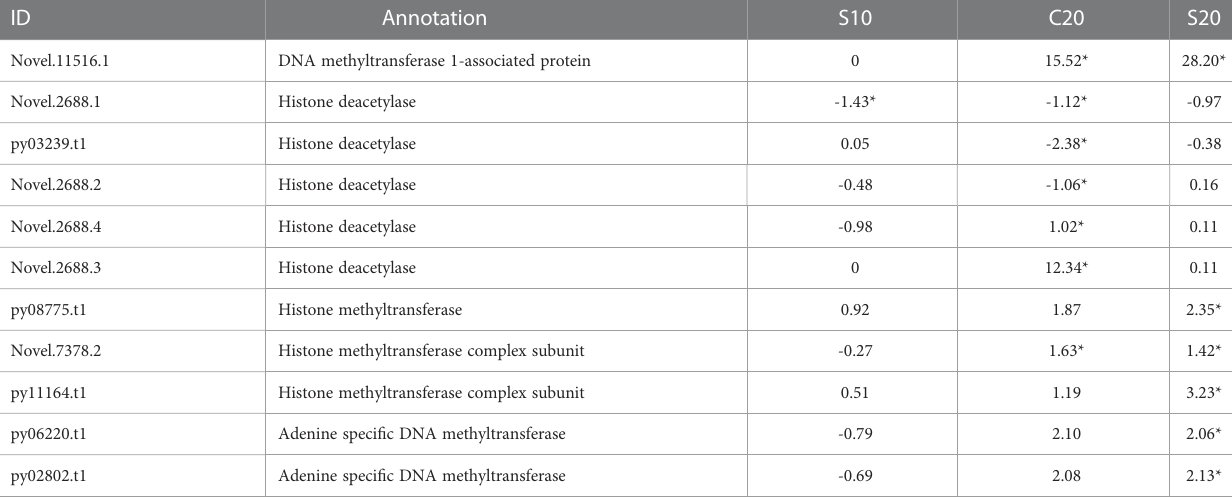
TABLE 1 Expression (Log 2 Foldchange value) of DEGs related to epigenetic modi fi cation under different conditions.